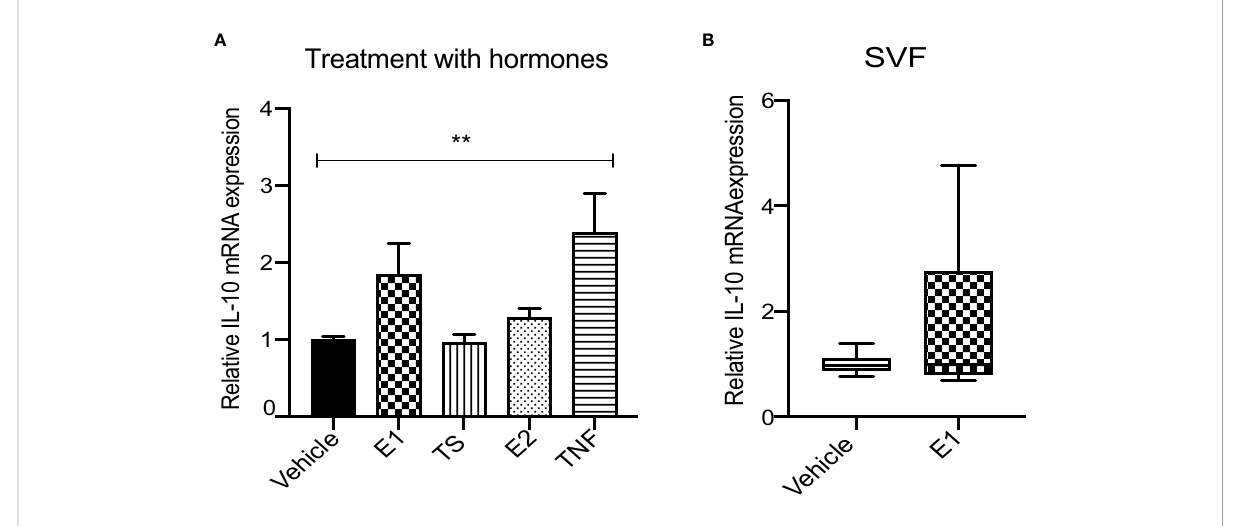
FIGURE 3 E1 has no effect on IL-10 expression neither in in vitro stimulated THP-1 macrophages nor in primary WAT SVF. (A) Relative IL10 mRNA expression in E1, TS, E2 and TNF a -treated THP-1 macrophages. Two-way ANOVA with Sidak ’ s multiple comparison was used to test the signi fi cance. ** <0.01 (n=4). (B) Relative IL10 mRNA in E1-stimulated WAT SVF; (Mann-whitney test, n=4 subjects in